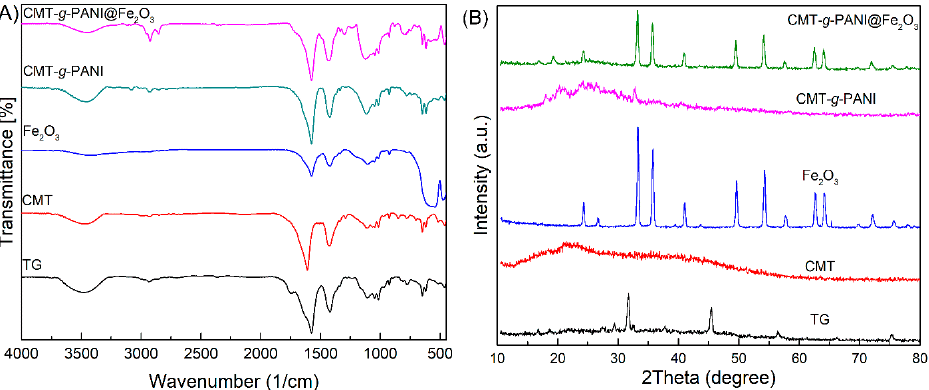
Figure 2. FTIR spectra ( A ) and XRD patterns ( B ) of TG, CMT, Fe 2 O 3 , CMT-g-PANI, and CMT-g- PANI@Fe 2 O 3 .